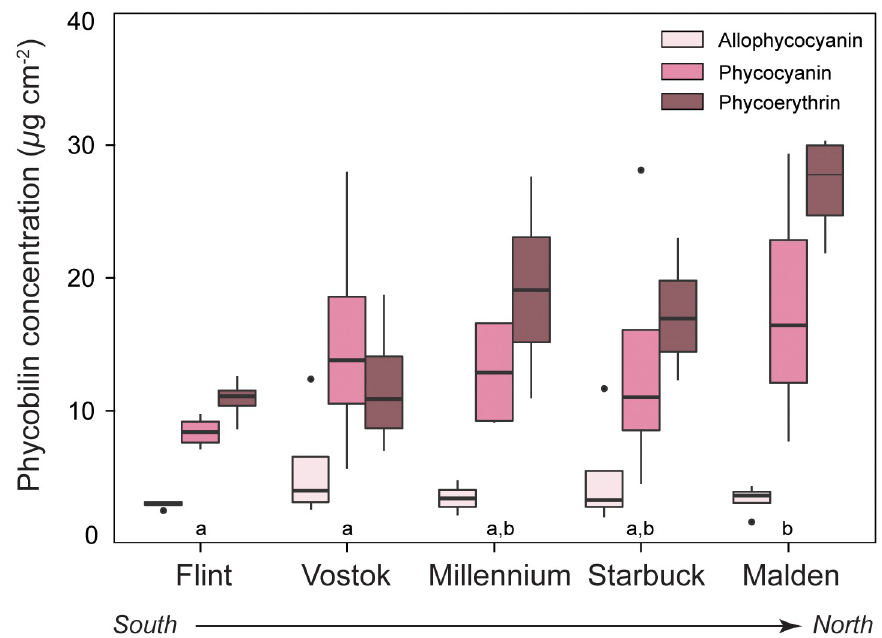
Fig 5. Phycobilin pigment concentrations. Mean ( ± SE) phycobilin pigment concentrations normalized to surface area for the crustose coralline alga Porolithon sp. across the Southern Line Islands. Islands are ordered from south to north. Allophycocyanin (light pink), phycocyanin (pink), and phycoerythrin (dark pink) were measured on 2 subsamples of each individual ( n = 4) per island. Data points are means of subsamples per individual. Significant differences in pigment concentrations across islands were determined for each pigment with Tukey’s HSD. Different letters represent significant differences at p < 0.05.